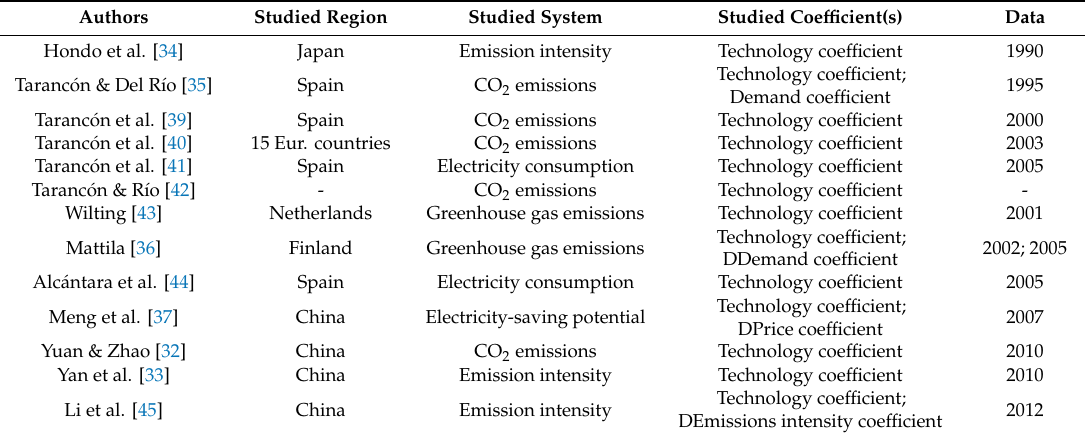
Table 2. Previous studies using input-output (IO)-based sensitivity